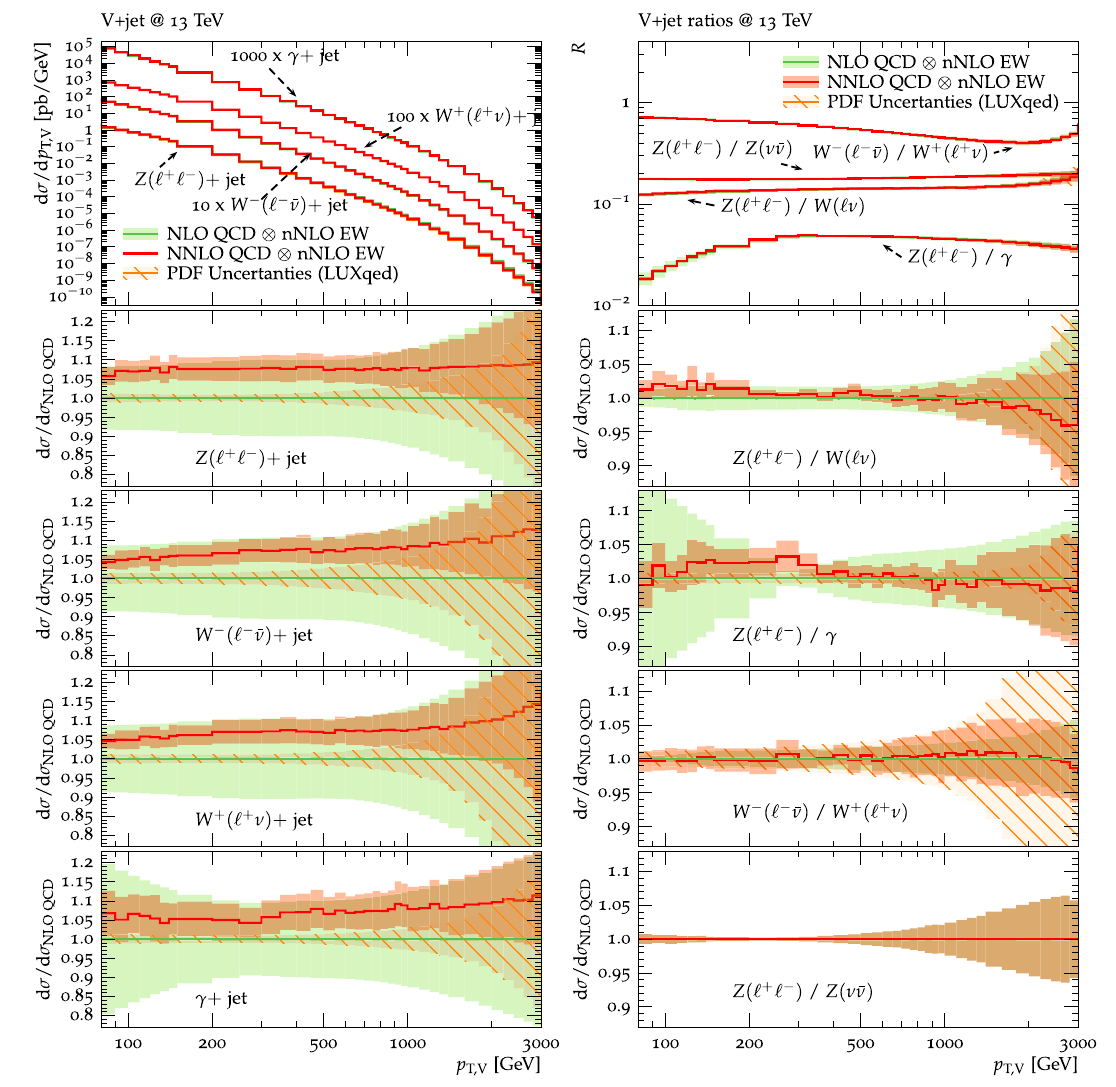
Fig. 17 Predictions at NLO QCD ⊗ nNLO EW and NNLO QCD ⊗ nNLO EW for V + jet spectra (left) and ratios (right) at 13TeV. ThelowerframesshowtherelativeimpactofNNLOcorrectionsandthe- ory uncertainties normalized to NLO QCD ⊗ nNLO EW. The green and redbandscorrespondtothecombination(inquadrature)oftheperturba-